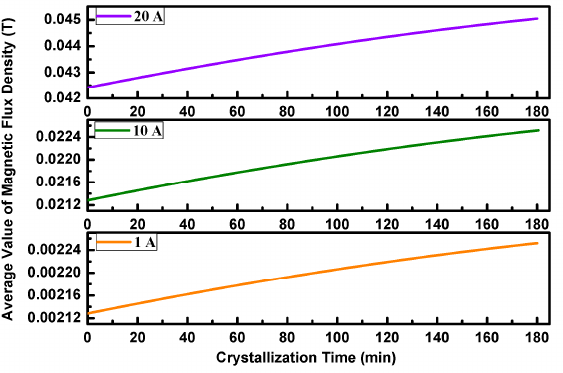
Figure 3. Direction of the magnetic field in the directional solidification system: ( a ) magnetic field in the total system; ( b ) magnetic field in the silicon.